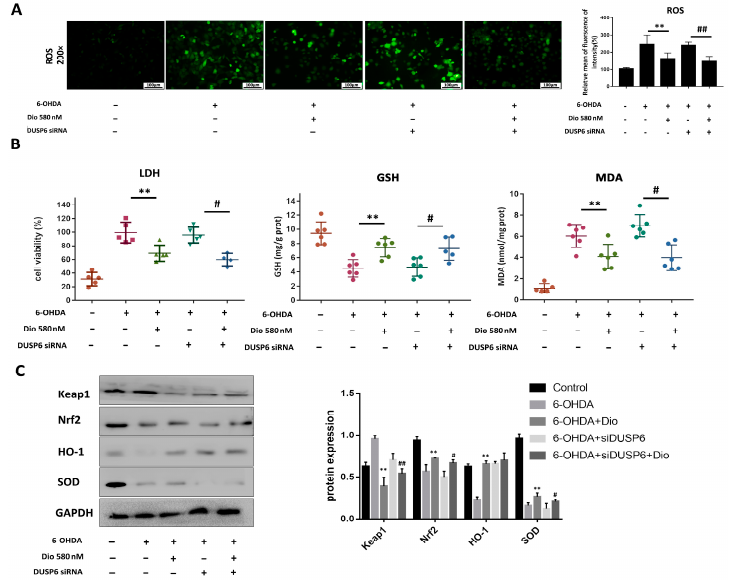
Figure 9. DUSP6 siRNA affected the neuroprotective effect of dioscin on the 6 ‐ OHDA ‐ induced oxidative stress injury in PC12 cells. ( A ) Effects of dioscin on the ROS level after DUSP6 siRNA transfection ( n = 3). ( B ) The levels of LDH, GSH and MDA in PC12 cells after DUSP6 siRNA transfection ( n = 6). ( C ) Effects of dioscin on the expression levels of Keap1, Nrf2, HO ‐ 1 and SOD after DUSP6 siRNA transfection ( n = 3). Data are expressed as the mean ± SD.** p < 0.01 compared with the 6 ‐ OHDA group; # p < 0.05 and ## p < 0.01 compared with the 6 ‐ OHDA+DUSP6 siRNA group.